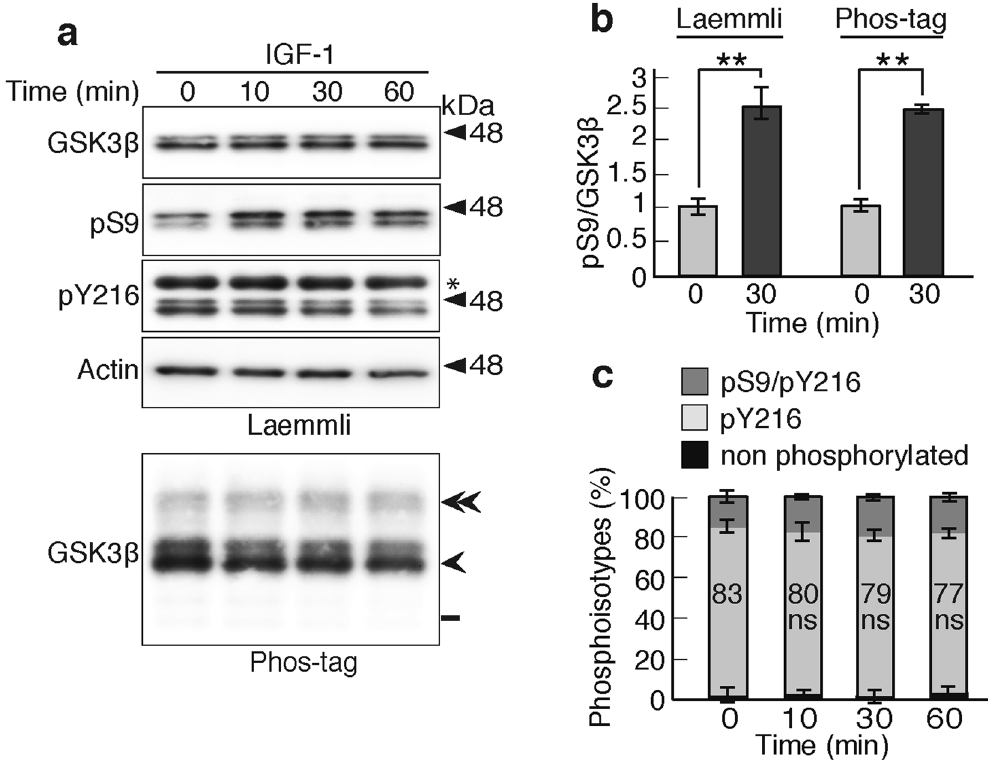
Figure 6. Effect of IGF-1 on GSK3 β activity in cultured primary neurons. ( a ) Effect of IGF-1 on Ser9 phosphorylation of GSK3 β in mouse cortical neurons. Neurons in culture at 5 DIV were treated with 100 ng/ml IGF-1 for the indicated times, and the extracts were subjected to Laemmli’s SDS-PAGE, followed by immunoblotting with an anti-GSK3 β , anti-phospho-Ser9 and anti-phospho-Tyr216 or Phos-tag SDS-PAGE, followed by immunoblotting with the anti-GSK3 β . Actin is the loading control. An asterisk in the pY216 indicates GSK3 α . Double arrowhead, Ser9/Tyr216-phosphorylated GSK3 β ; arrowhead, Tyr216-phosphorylated GSK3 β ; bar, nonphosphorylated GSK3 β . ( b ) Levels of pSer9 in neurons that were treated with IGF-1 for 30 min. The ratio of pS9/GSK3 β was measured and expressed to that of the control at 0 min. The measurements by Laemmli’s and Phos-tag SDS-PAGE are shown in left and right, respectively. ( c ) The quantification of three phosphoisotypes of GSK3 β in a Phos-tag blot: dark gray, phospho-Ser9/phospho-Tyr216; light gray, phospho- Tyr216; black, nonphosphorylated GSK3 β . The percentages of phospho-Tyr216 are indicated (means ± s.e.m. n = 6, ns, not significant). Uncropped immunoblots of GSK3 β , pS9, pY216 and actin after Laemmli’s SDS-PAGE and GSK3 β after Phos-tag SDS-PAGE are provided in Supplementary Fig.